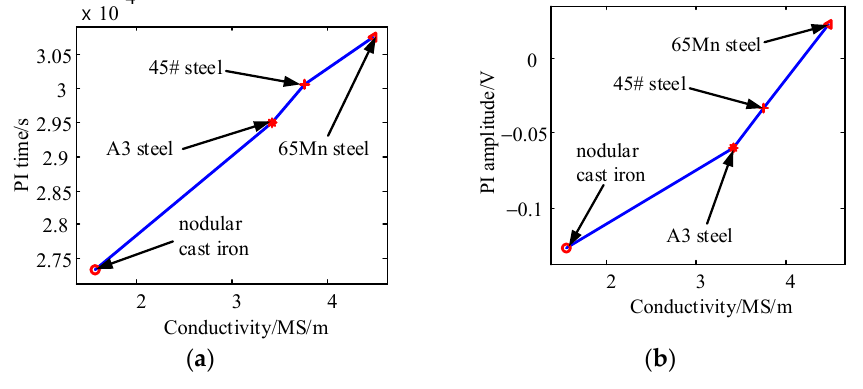
Figure 18. PIs with samples of different materials. ( a ) PI time curve; ( b ) PI amplitude curve.